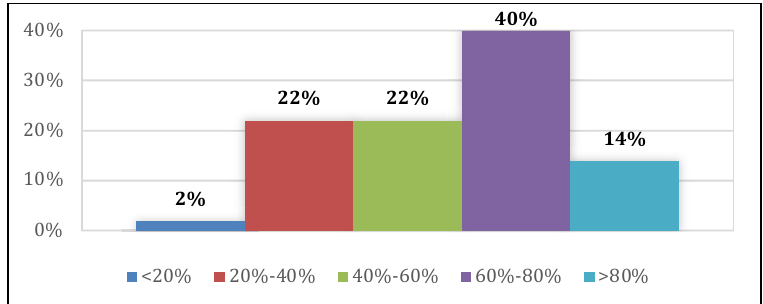
Fig. 5. Students perception of the amount of project material covered during formal classes